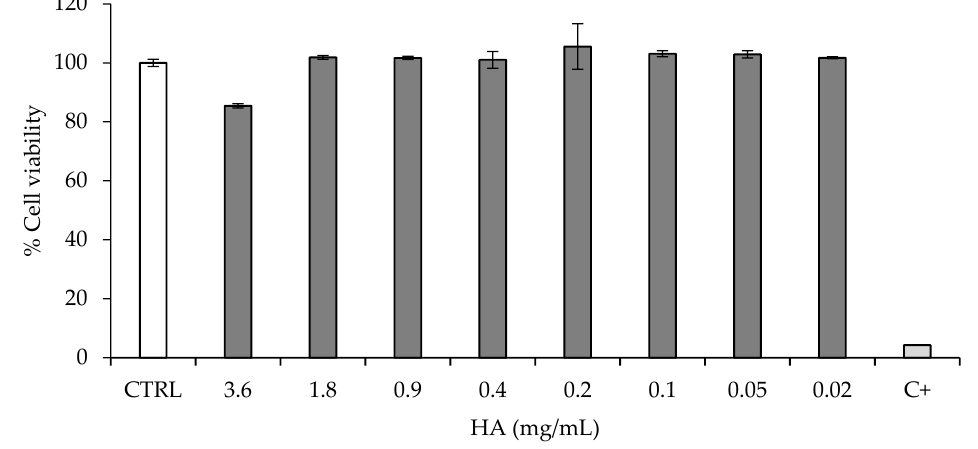
Figure 4. Cytotoxicity of HydC at different concentrations on human urothelial cells (HTB-4) 24 h after treatment. CTRL: HTB-4 in basal medium; C+: SDS (0.5 mM).